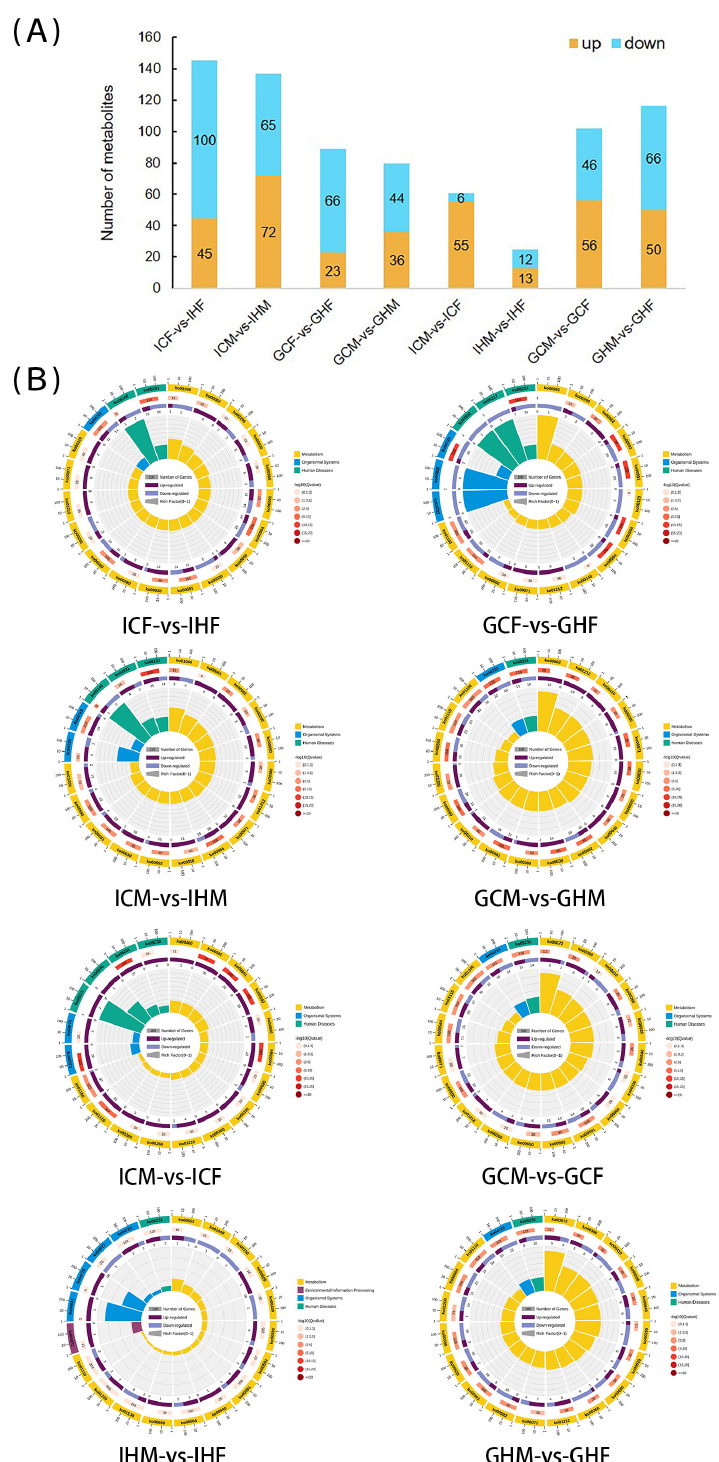
Figure 3. Differential intestinal and gonadal metabolites and enrichment pathways in sea cucumbers. ( A ) Comparison of differential metabolites between experimental groups. ( B ) The top-20 most-enriched differential metabolite pathways between the experimental groups. Sex also affected the intestinal and gonadal metabolites of A. japonicus , with 55 upregulated and 6 downregulated metabolites in ICF versus ICM; 13 upregulated and 12 downregulated metabolites in IHF versus IHM; 56 upregulated and 46 downregulated